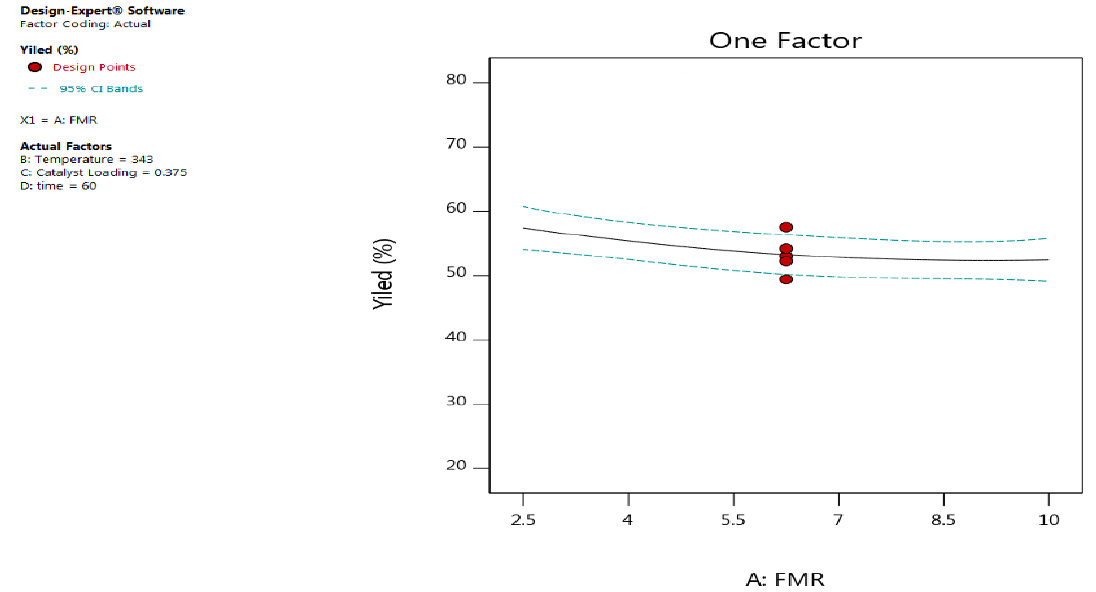
Figure 5. The effect of feed molar ratio on the yield of 1,2-epoxy-5-hexene.